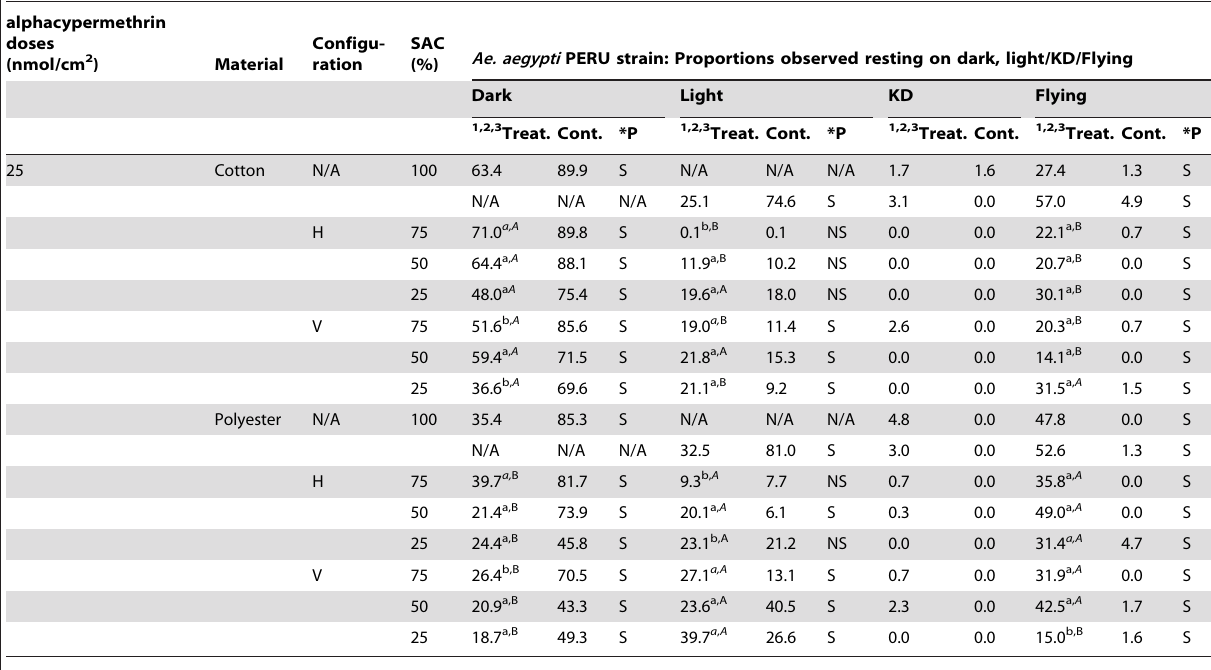
* x 2 test P comparing resting on the dark material under treatment versus matched control conditions. Treat. = Treatment; Cont. = Control. 1 Small capital letter compares resting observation in dark:light; KD and mosquitoes observed flying when dark material are in vertical versus horizontal configuration in treatment conditions. Same small capital letter on the same column at the same SAC, material type, chemical and dose means percent observed resting not significantly different. 2 Capital letter compare resting observation in dark:light, KD and mosquitoes observed flying when cotton is used versus polyester in treatment conditions. Same capital letter on the same column at the same SAC, configuration, chemical and dose means percent observed resting not significantly different. 3 Letter in italic refers to the value significantly high. S = P , 0.05; NS = P . 0.05; N/A = Not applicable; SAC = surface area coverage; H = horizontal; V = vertical; N =60 from a total of 6 replicates performed for